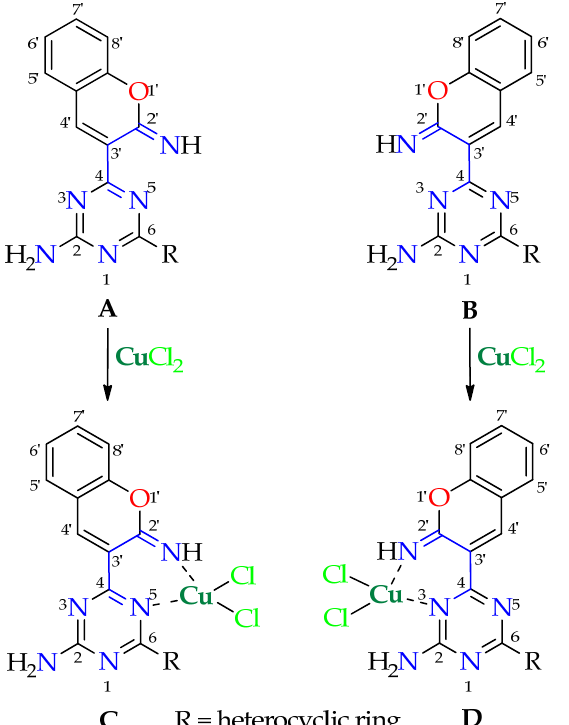
Figure 2. Two possible conformations C and D of copper(II) complexes of 2-iminocoumarin-1,3,5-triazines.